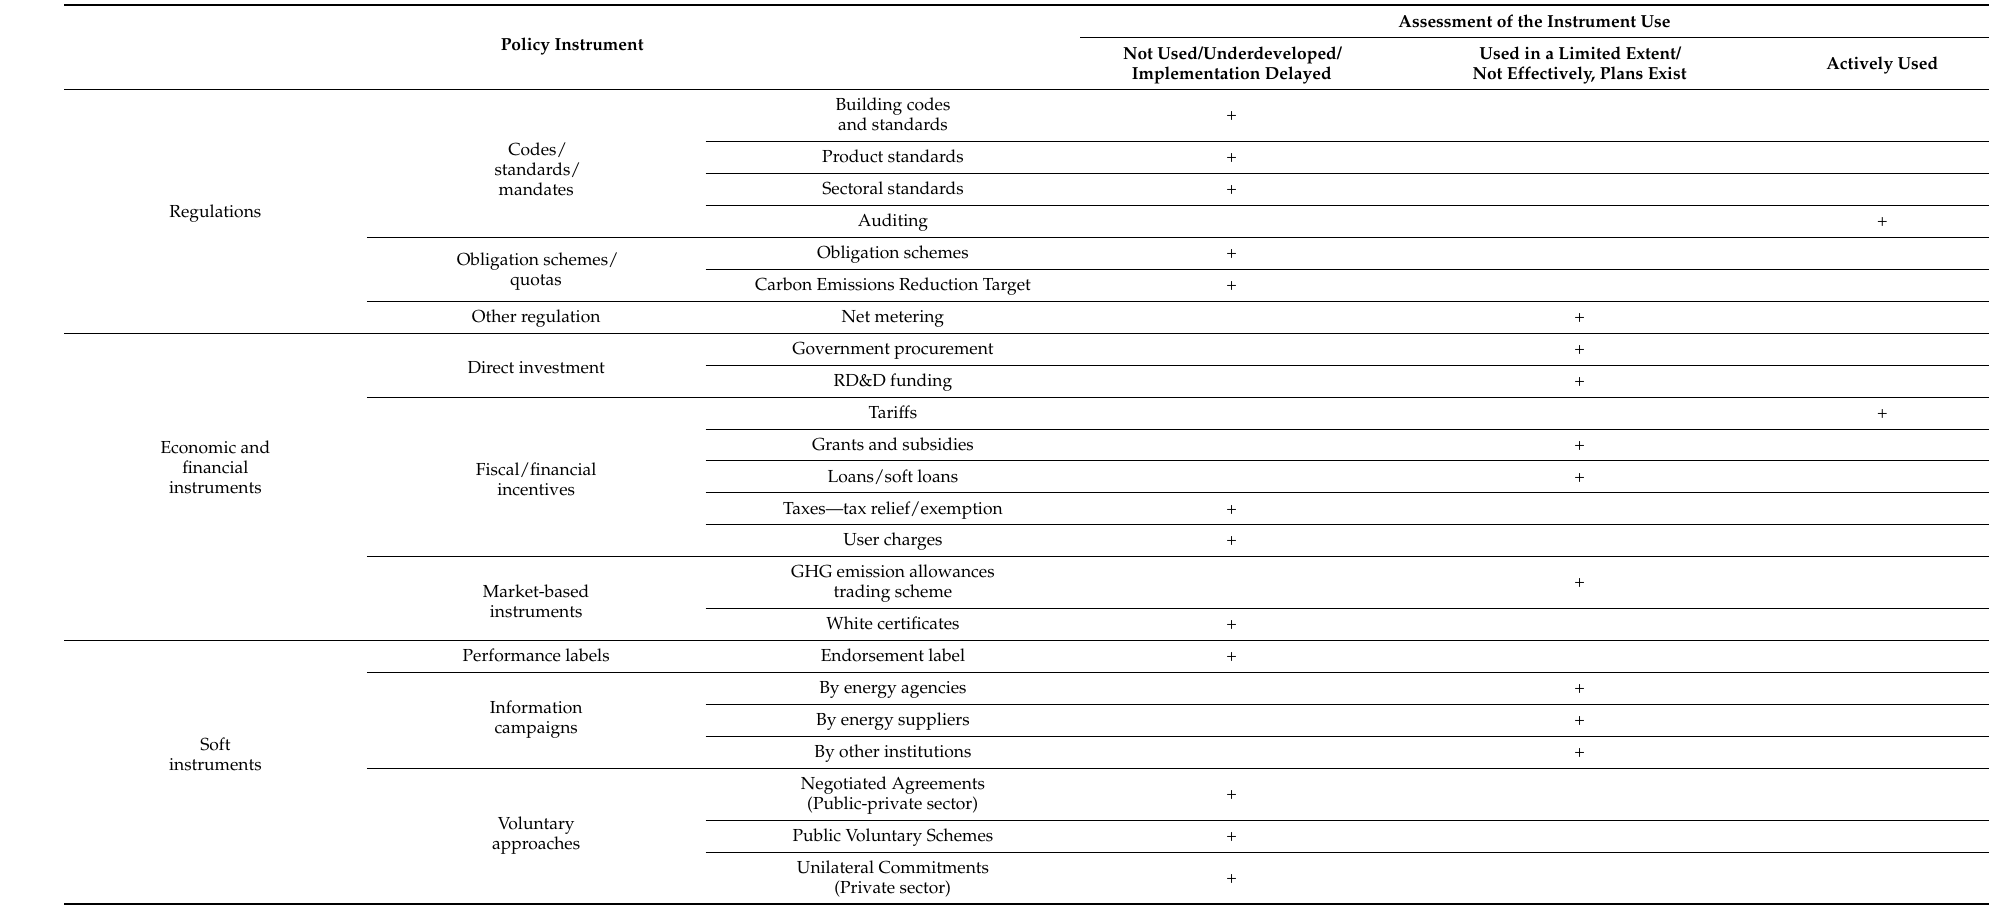
Table 3. Assessment of policy instruments addressing SM TIS in